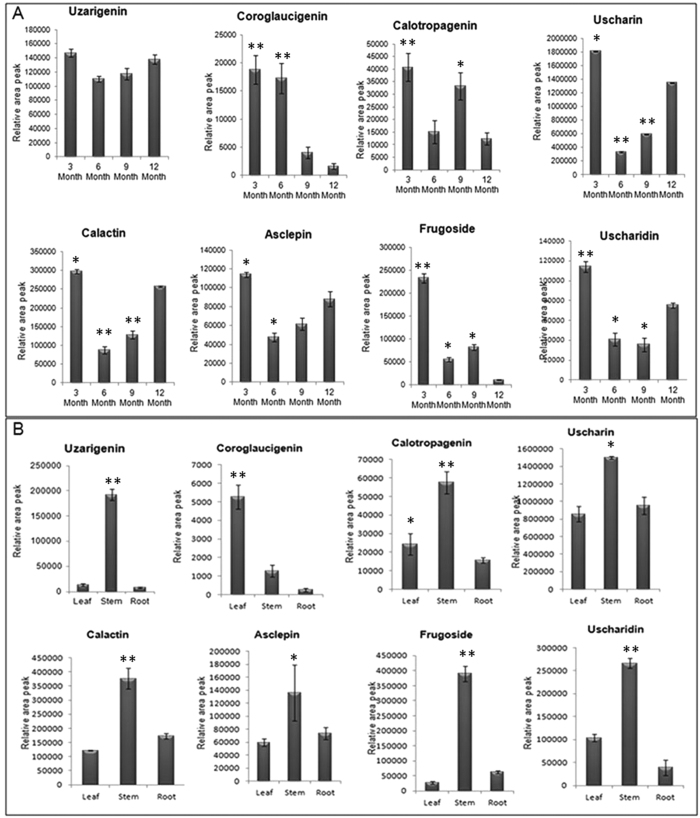
(A) Accumulation of CGs and genin units at different stage of C. procera plant measured with LC-MS/MS. (B) Tissue-specific Accumulation profiling of CGs and genin units in C. procera plant measured with LC-MS/MS. Each value is the mean of three replicates, and error bars indicate SDs. Asteriks *(P < 0.05) and **(P < 0.001) indicate significant differences as determined by Student’s t test. (M + H)+ denote parent ions of different CGs as Uzarigenin (375), Coroglaucigenin (391) Calotropagenin (405), Uscharidin (531), Calactin (533), Uscharin (586), Frugoside (537) and Ascelpin (575).